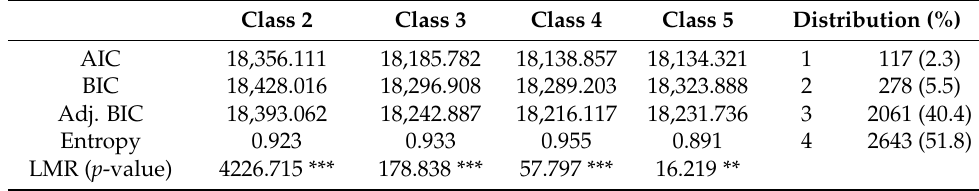
Table 1. Latent Class Analysis Results (n =